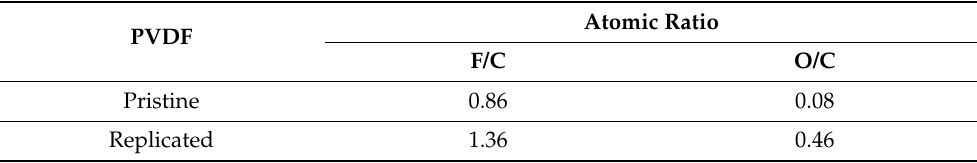
Table 2. C/F and O/C ratio in the pristine and replicated